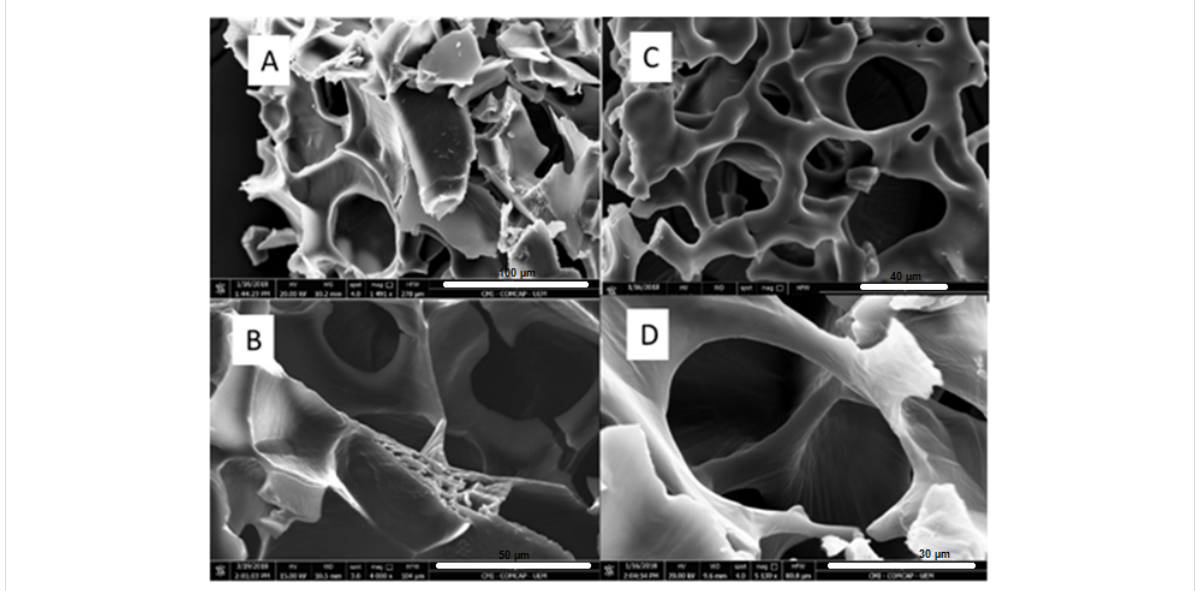
Figure 4: SEM micrographs of systems containing 15% (w/w) P407, 0.25% (w/w) C974P: without CUR original magnification ×1500 (A, scale bar = 100 µm) and ×4000 (B, scale bar = 40 µm); containing CUR original magnification ×1800 (C, scale bar = 50 µm) and ×5000 (D, scale bar = 30